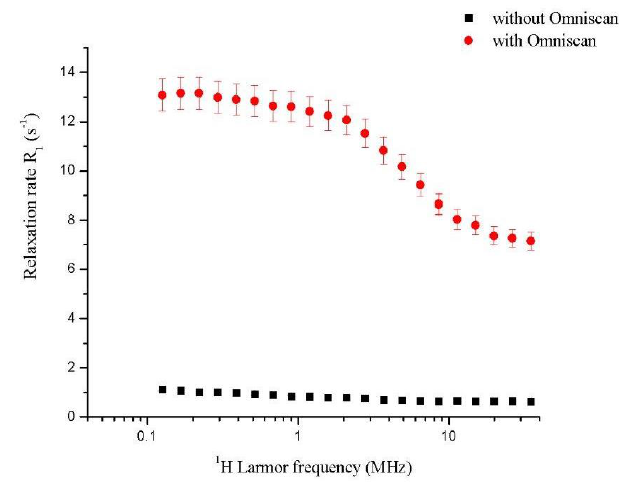
Figure 1. 1 H-NMRD profile for homogenate rat heart: Without perfusion of Omniscan and with perfusion of Omniscan. For all relaxation rate values, the error bar (5%) was reported.